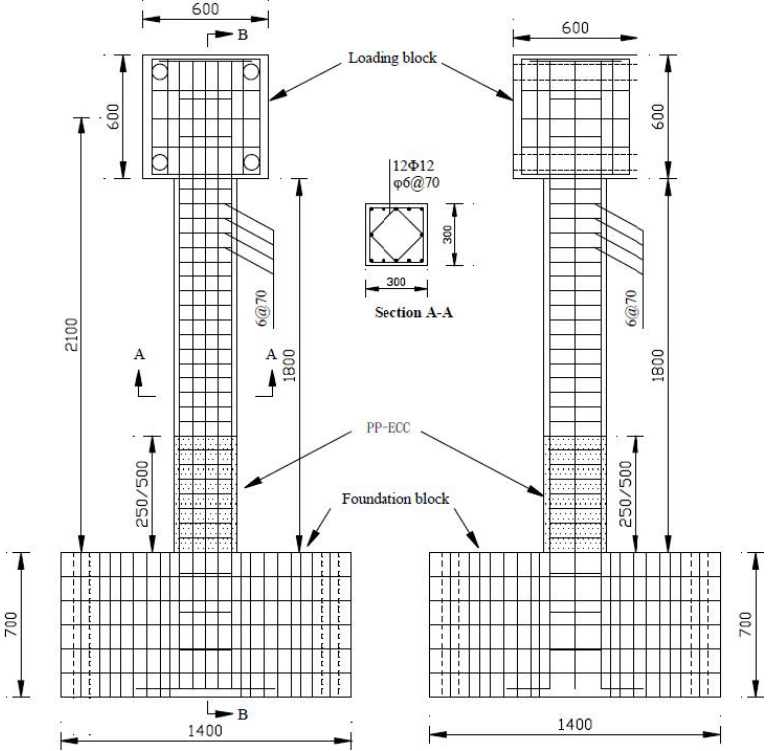
Figure 1. The stirrup is made of steel plate hoops, and the steel plate hoop is 3 mm thick Q235 steel [3].